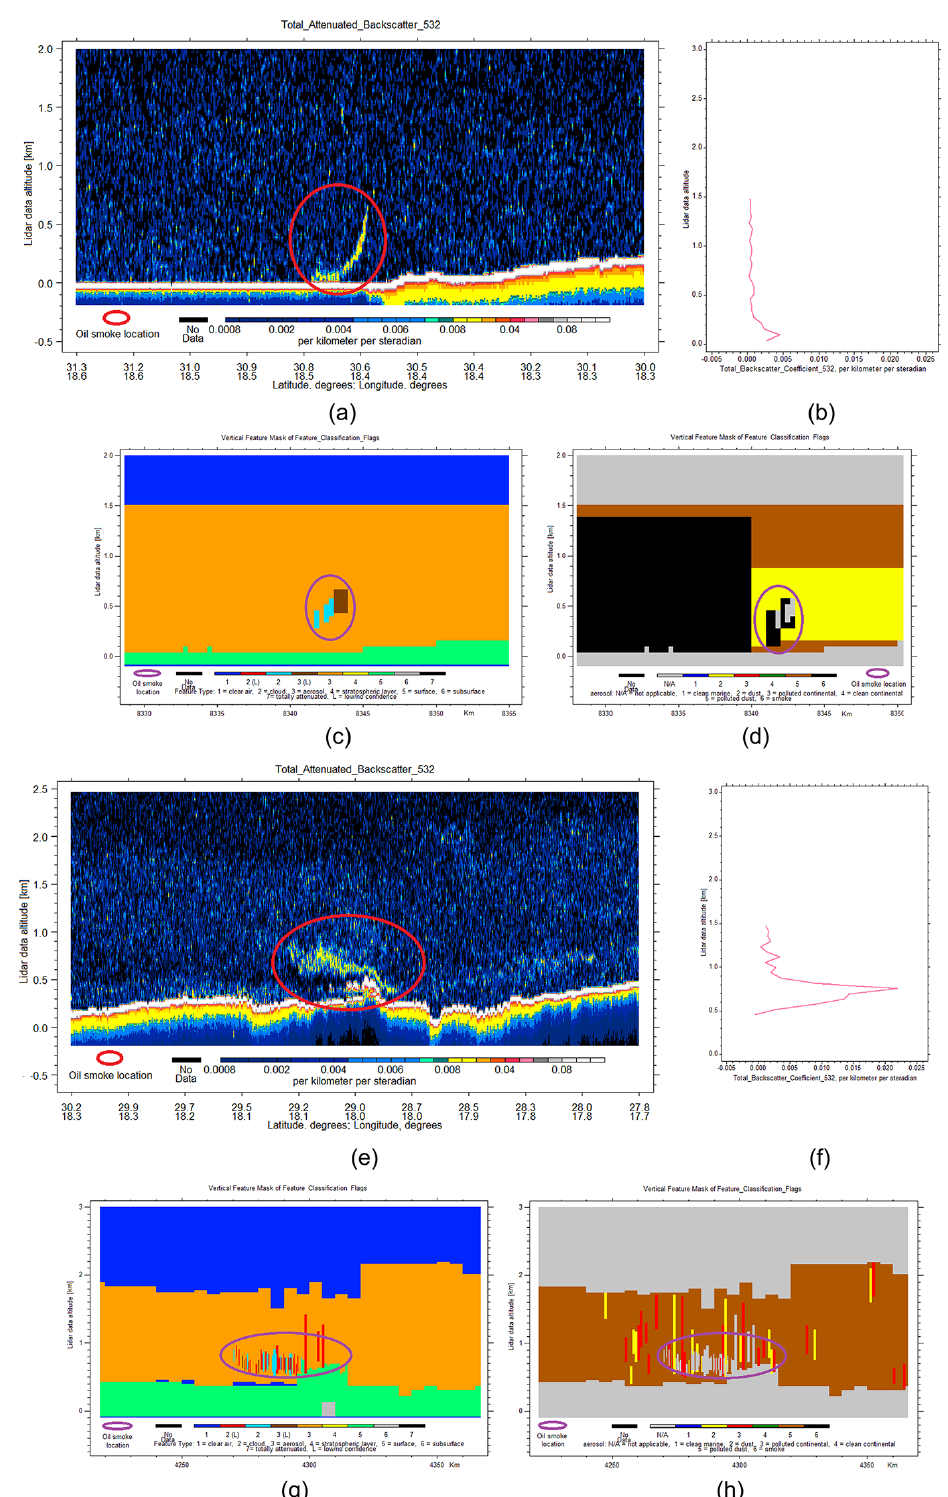
Figure 8. Image of event 13 (a) based on CALIPSO total attenuated backscatter (532nm) vs. lidar data altitude data. (b) Particulate backscat- ter coefficient profile CALIPSO level 2 (532nm) at As Sidr. (c) Cloud feature classification and (d) aerosol feature classification at As Sidr. (e) Image of event 11, based on CALIPSO total attenuated backscatter (532nm) vs. lidar data altitude data. (f) Particulate backscatter coefficient profile CALIPSO level 2 (532nm) at Ra’s Lanuf. (g) Cloud feature classification and (h) aerosol feature classification at Ra’s Lanuf.